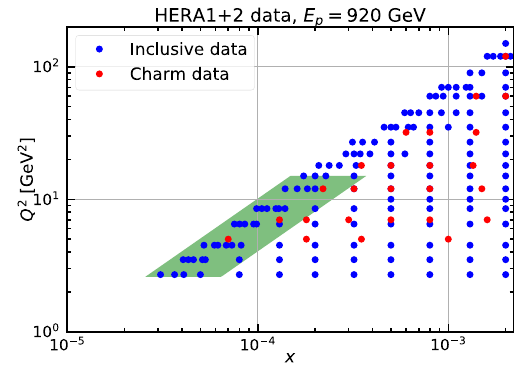
Fig. 12 Scatterplotofthelow- x andlow- Q 2 kinematicregioncovered by the HERA1+2 inclusive data and charm data at E p = 920 GeV. The green shaded area indicates the region in which ln ( 1 / x )